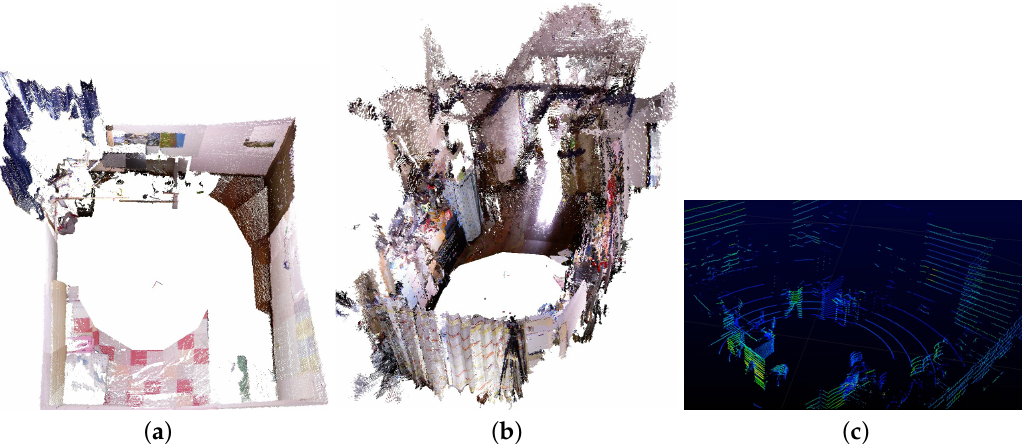
Figure 7. Reconstruction of a bedroom (3.3 m × 3 m) ( a ), and a living room (9 m × 3.5 m) ( b ) using only one output frame from the proposed panoramic 3D vision system. ( c ) Screenshot of the indoor point cloud generated from Velodyne VLP 16